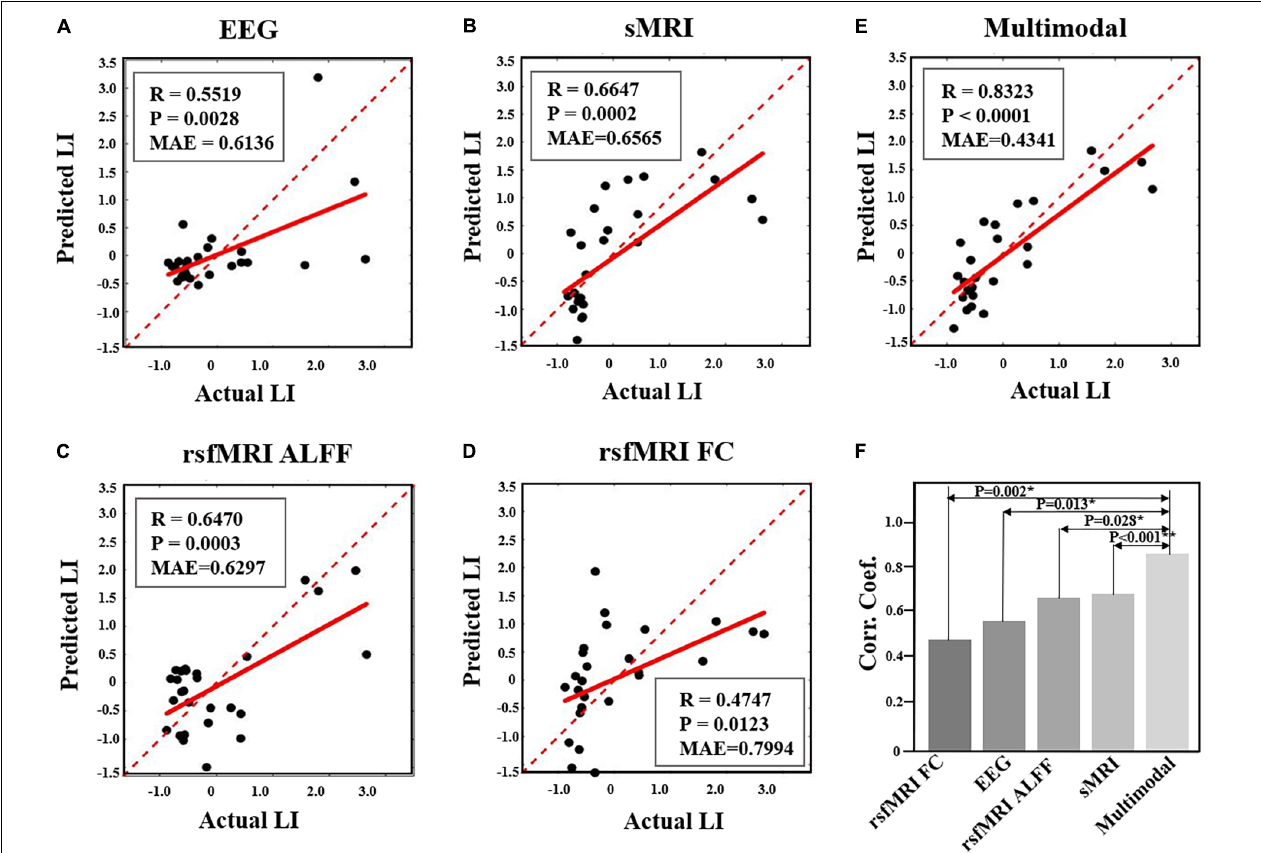
FIGURE 5 | Comparison of performance in prediction NFB within-session learning index LI using different feature sets. (A) . Prediction results using EEG features. (B) . Prediction results using sMRI features. (C) . Prediction results using rsfMRI ALFF. (D) . Prediction results using rsfMRI FC. (E) . Prediction results using multimodal neuroimaging features. The red dashed lines represent y = x while the red solid lines represent the regression lines. Each black dot represents one participant. (F) shows the comparison of correlation coefficients between predicted and actual LI values among five different feature sets (*, P < 0.05; **, P <